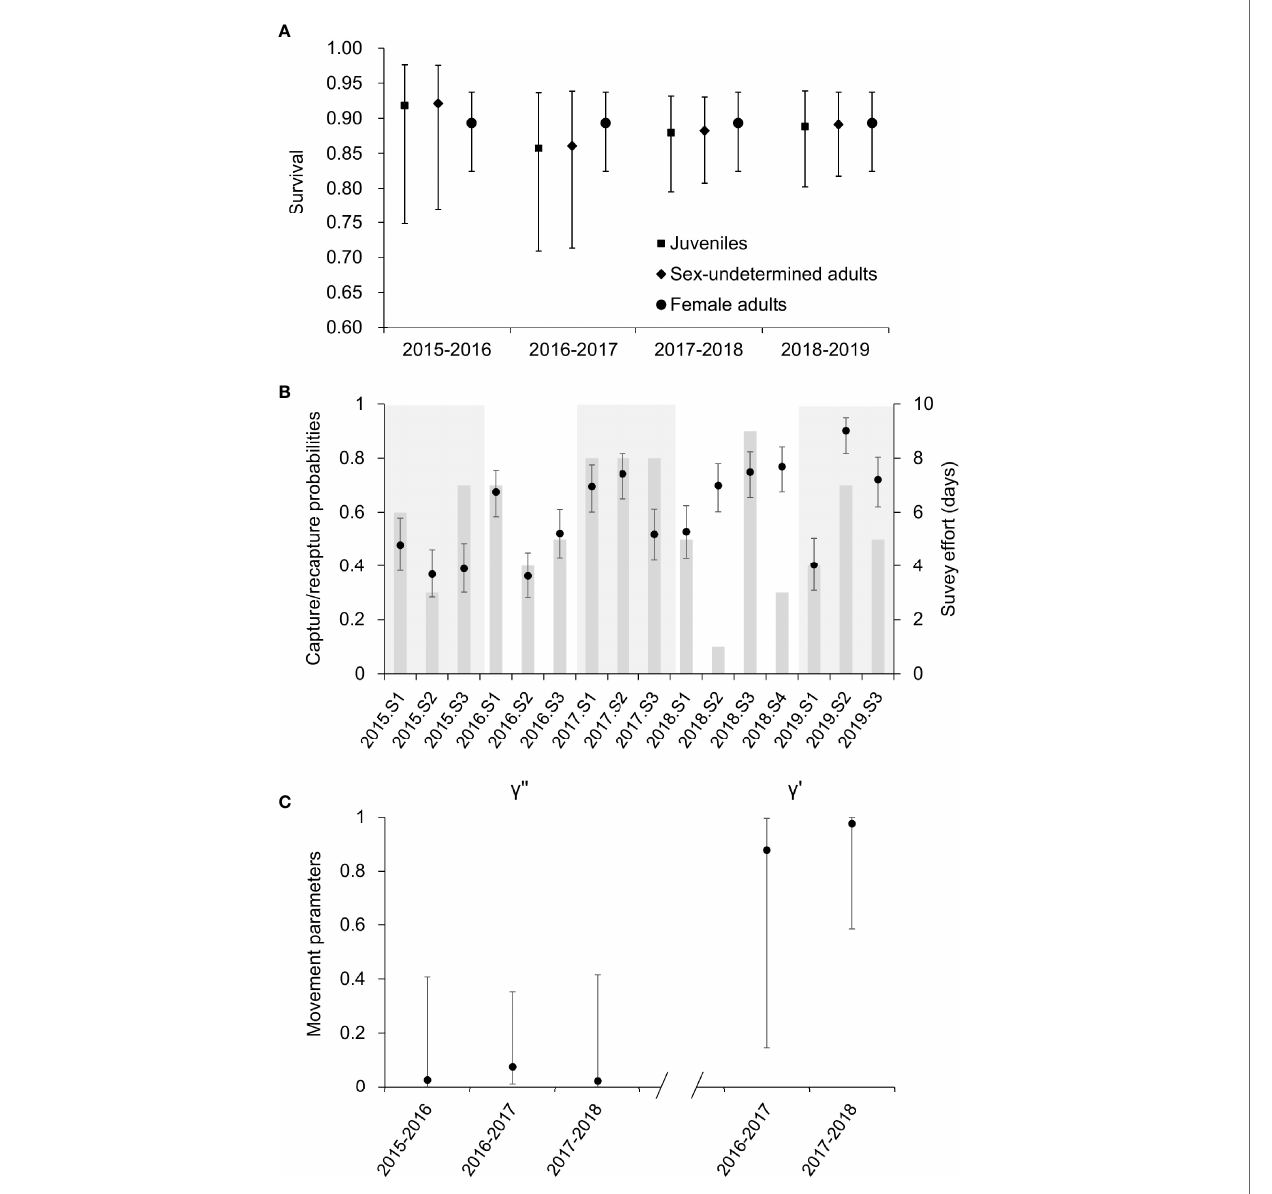
FIGURE 3 | Estimates for the (A) survivals, (B) capture probabilities, and (C) movement parameters of the DRE Indo-Paci fi c humpback dolphins during 2015 – 2019. The error bars indicate the 95% con fi dent intervals of estimates. In the middle panel, the capture probabilities of each session within a primary occasion were highlighted in different colors, while the survey effort (measured in the number of survey days) was presented in histogram according to the secondary